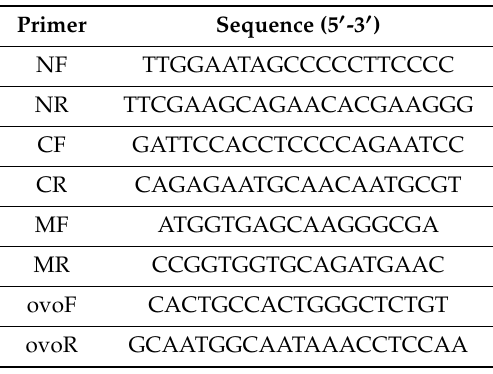
Table 1. List of primer